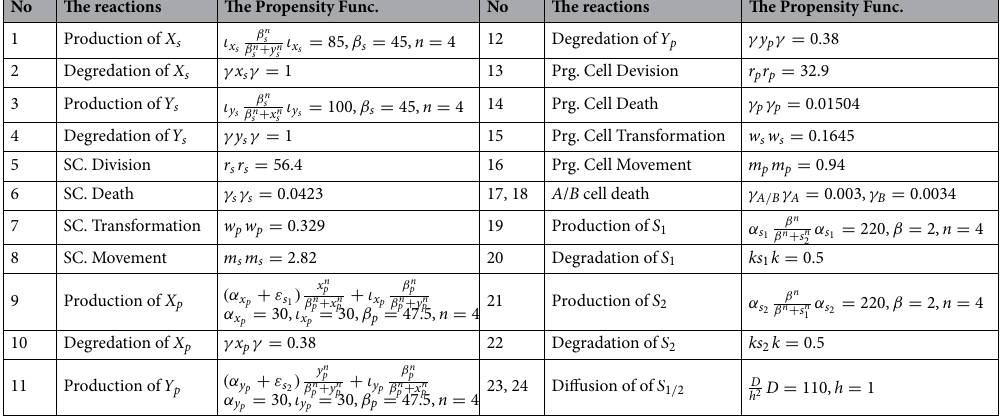
Table 1. The potential reactions of the system together with their corresponding propensity